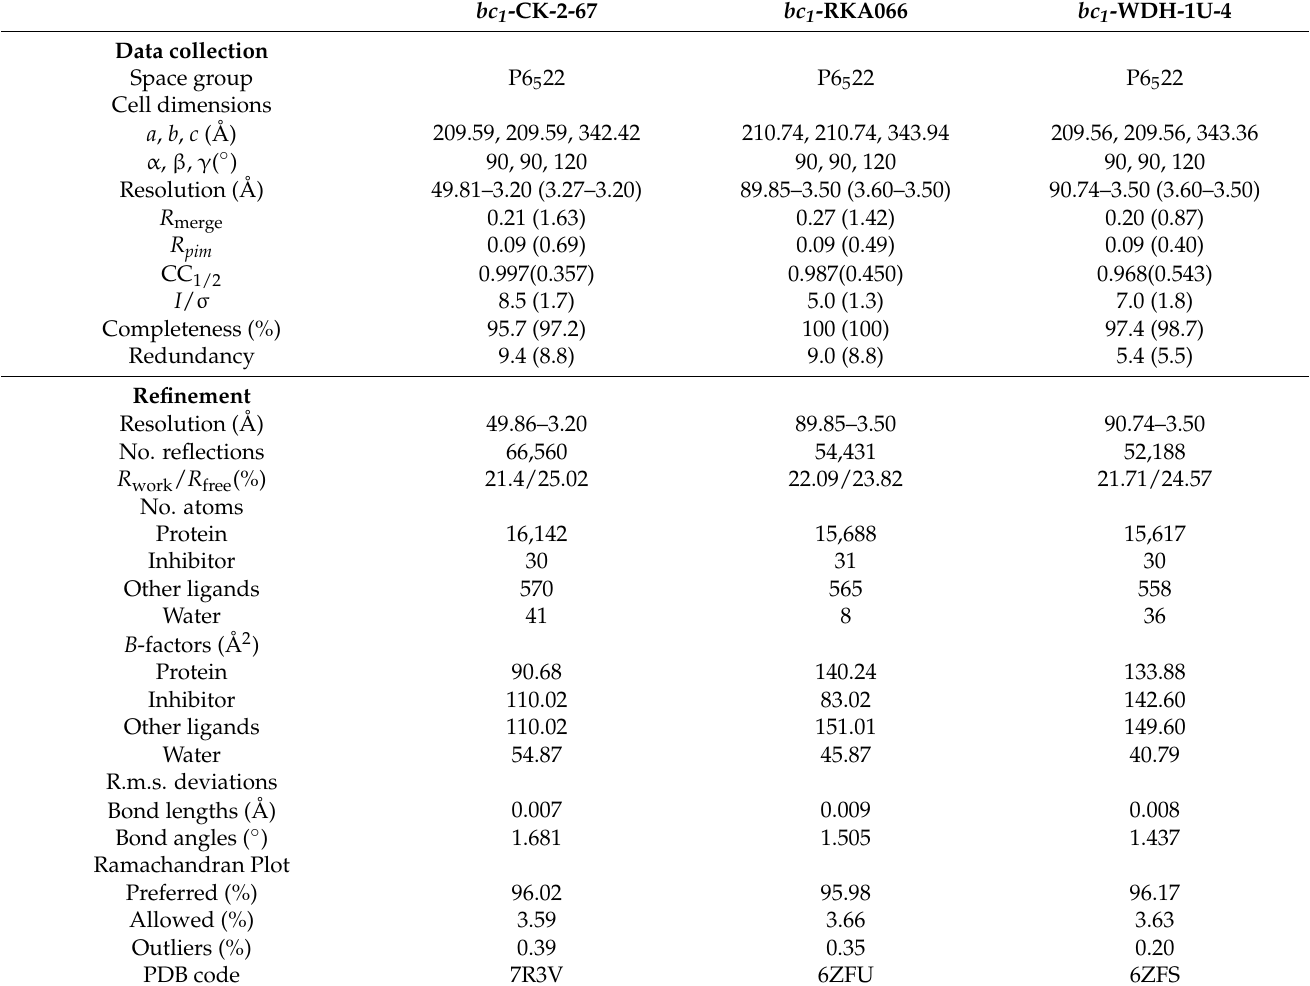
Table 2. Data collection and refinement